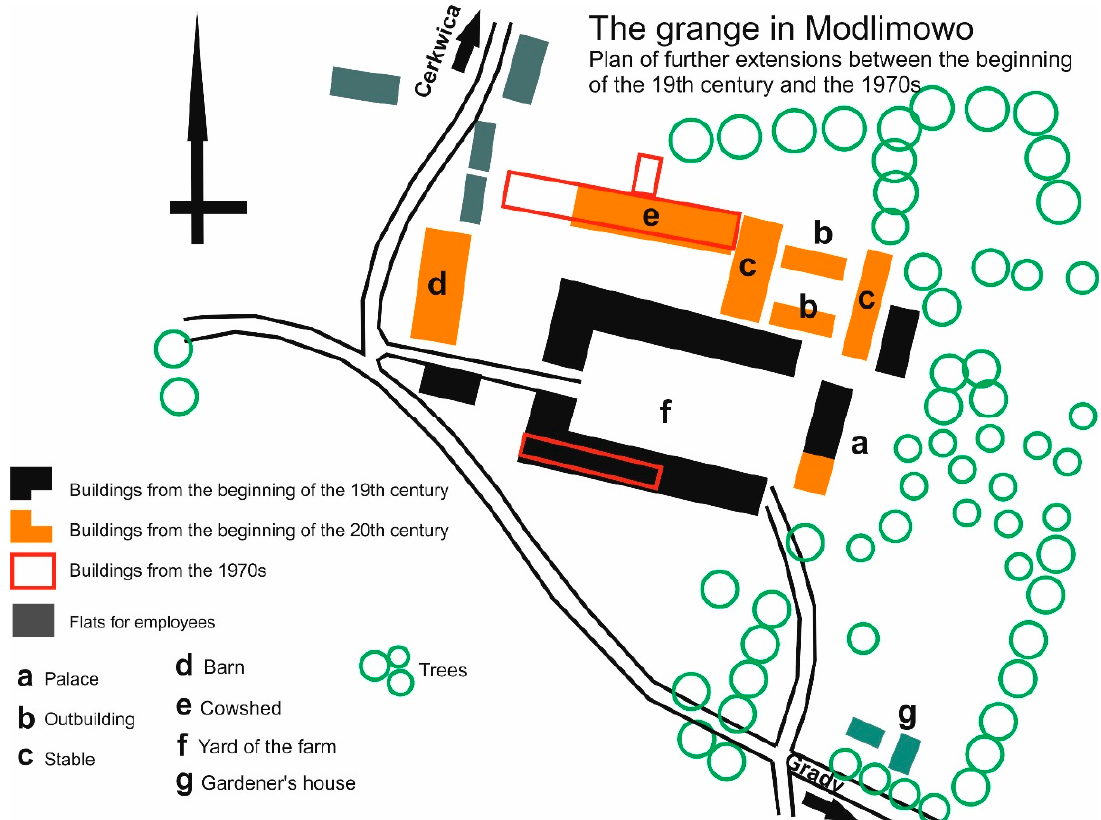
Figure 4. Plan for further expansion from the beginning of the 19th century to the 1970s. The map Scheme 1929. map the buildings are similar in shape to peasant houses, they differ in size. The grange was located in the south-eastern part of the village. Farm buildings were moved away from the road around the central square. The elongated rectangle courtyard was originally surrounded by farm buildings as well. On both sides, the long L-shaped farm buildings created a semi-circle open to the manor house.